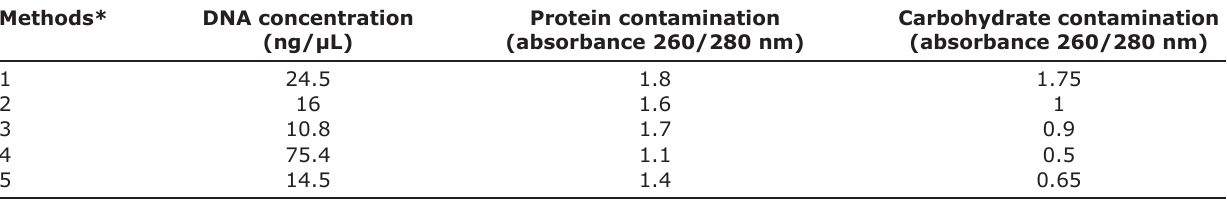
Table-1: Comparison of extracted DNA from hydatid cyst by five different methods.